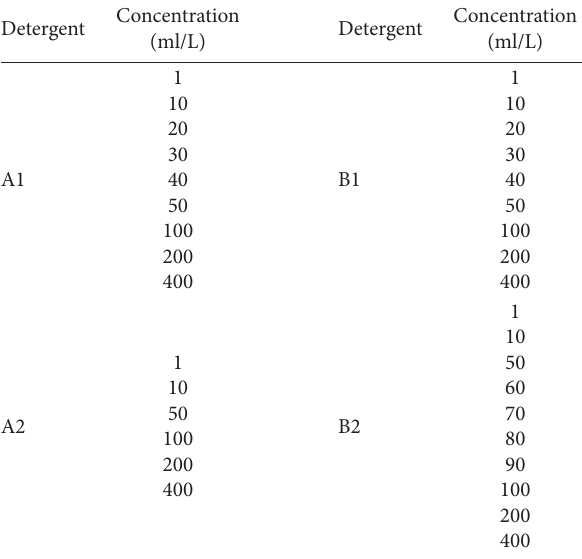
Table 2. The detergent concentrations used in determination of EC50